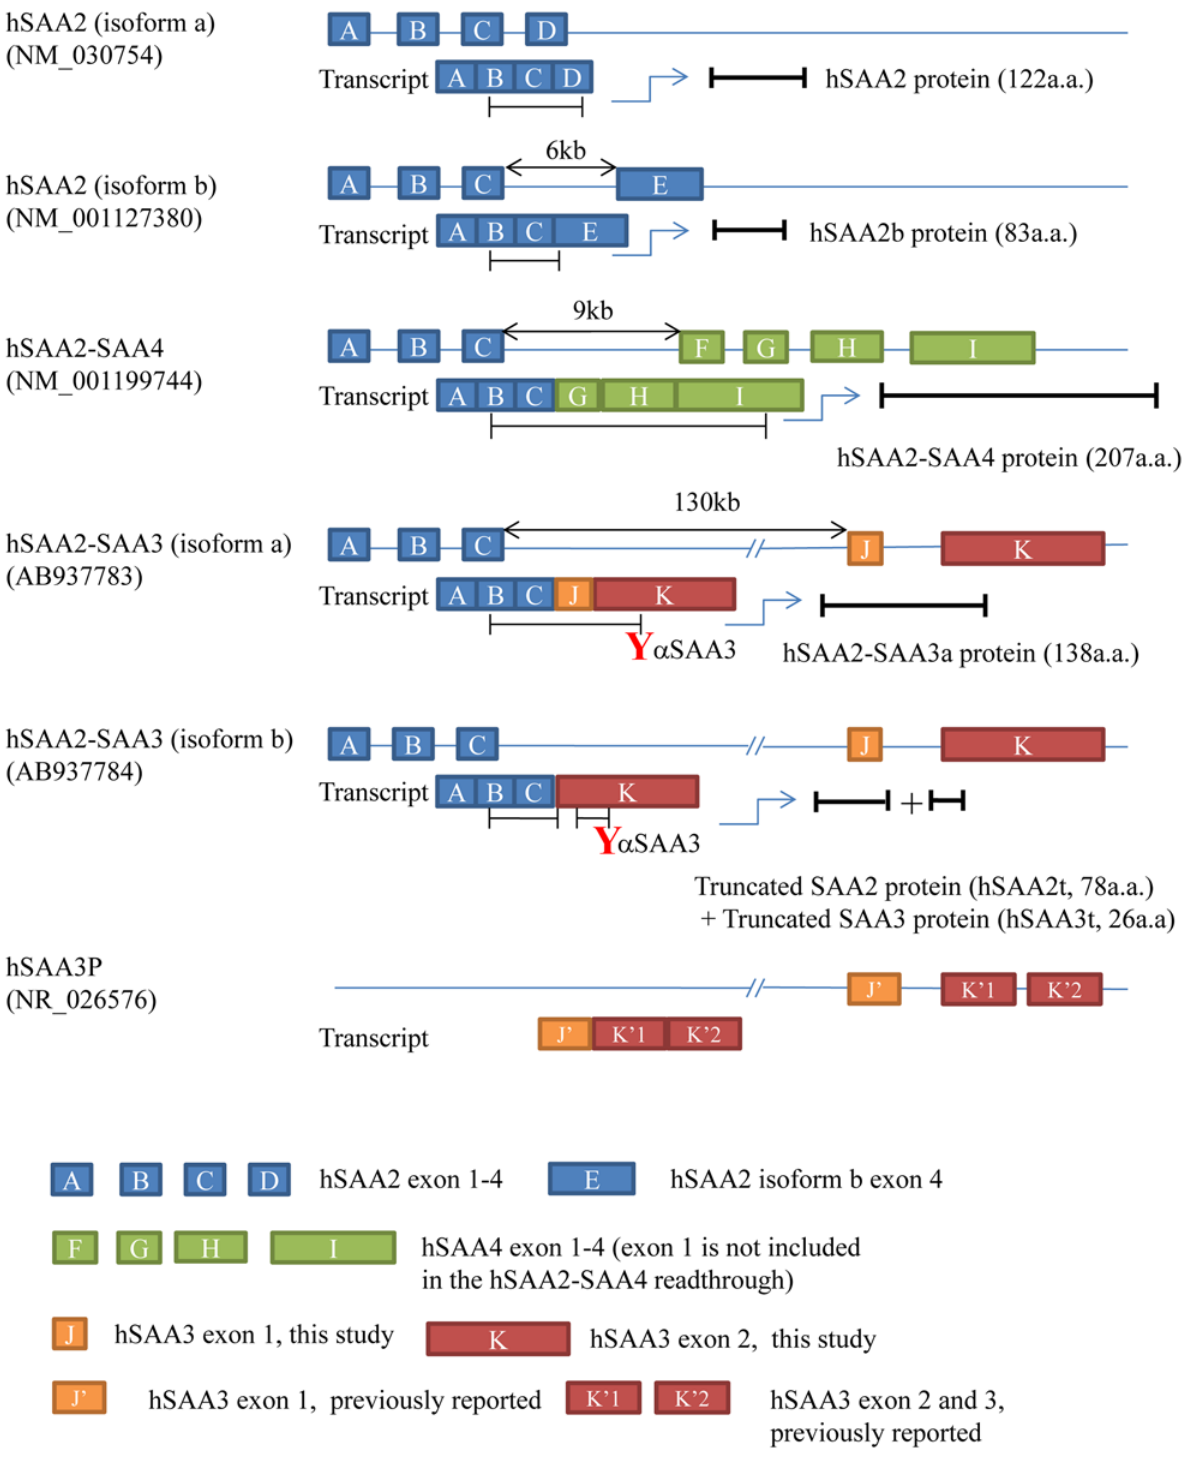
Fig 1. Structures of hSAA2-SAA3 readthroughs. A-K stand for exons in the hSAA2, hSAA3, or hSAA4 gene. Human SAA3 exon 1 (J) identified in the present study was 52 bp shorter than that previously reported (J ’ ). Human SAA3 exon 2 (K) in the present study contained intron between hSAA3 exon 2 (K ’ 1) and exon 3 (K ’ 2). The 5 ’ edge of (K) was identical to that of (K ’ 1), as was the 3 ’ edge of (K) to that of (K ’ 2). The bars under the transcripts represent open reading frames. As displayed in the figure, our hSAA3 antibodies recognize the C-terminal region of hSAA3.